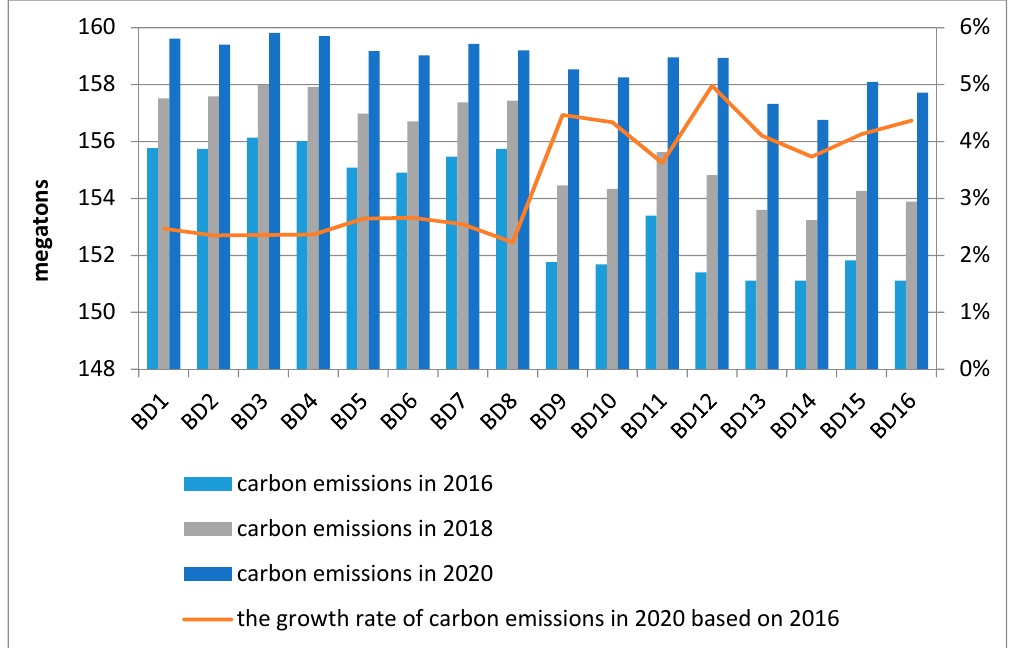
Figure 3. The prediction values of carbon emissions of Beijing for the base development scenarios in 2016, 2018 and 2020.